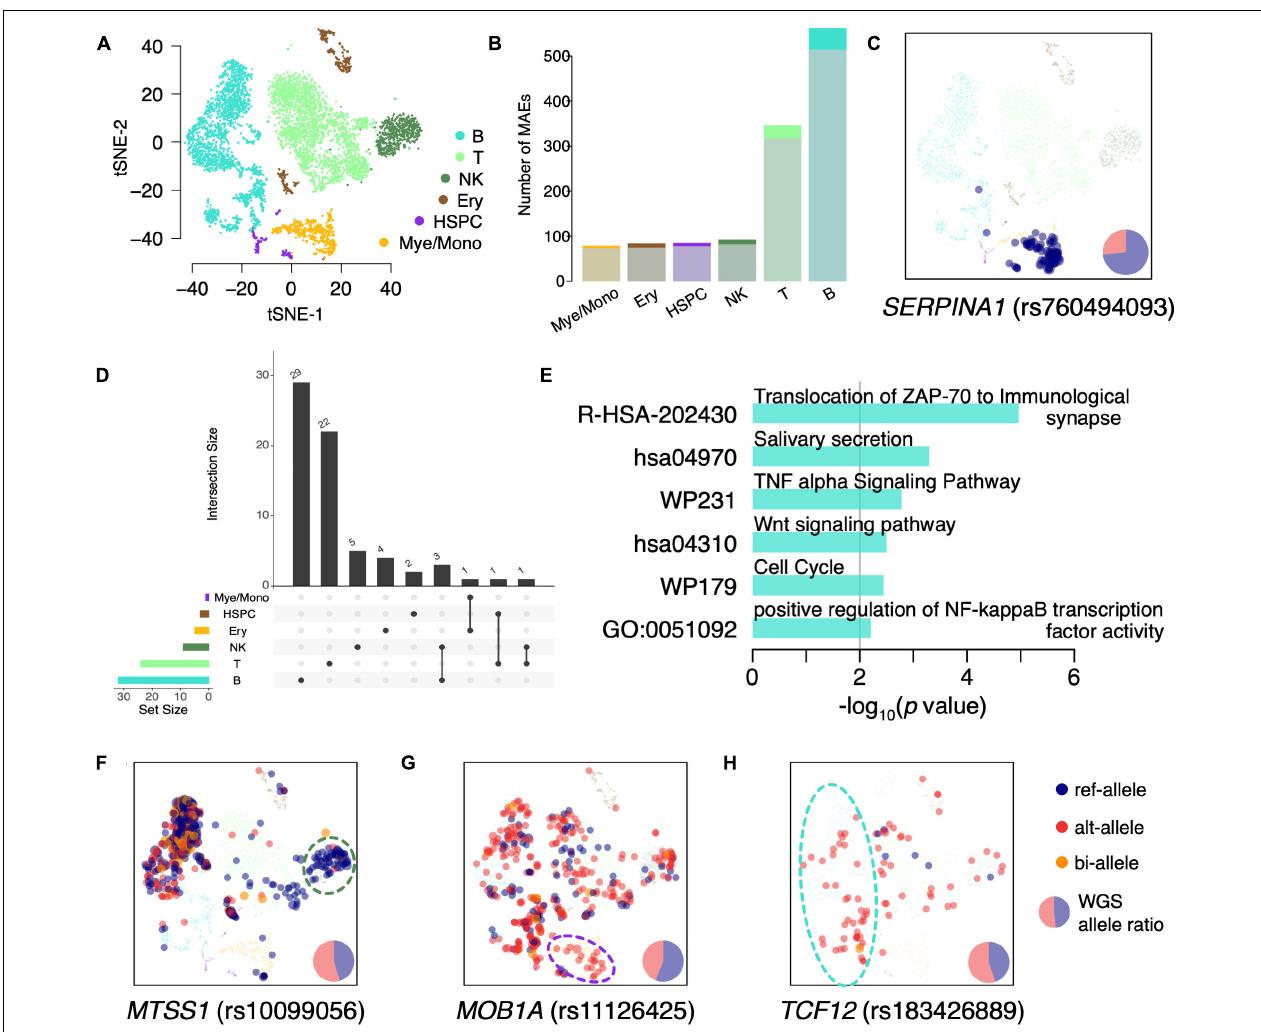
FIGURE 2 | Identification of cell type specific MAEs in BMMCs. (A) tSNE projection of BMMCs, colored by inferred major cell types. (B) Detected number of MAEs in each major cell type. The shadowed (bottom) and bright (top) colors indicate the constitutive MAEs in BMMCs and cell type specific MAEs, respectively. (C) tSNE projection of BMMCs, colored by expressed allele of SERPINA1 . (D) The upset plot of the cell type specific MAEs. (E) GO enrichment analysis of the B cell specific MAEs. (F – H) tSNE projection of BMMCs, colored by the expressed allele of MTSS1 (F) , MOB1A (G) , and TCF12 (H)